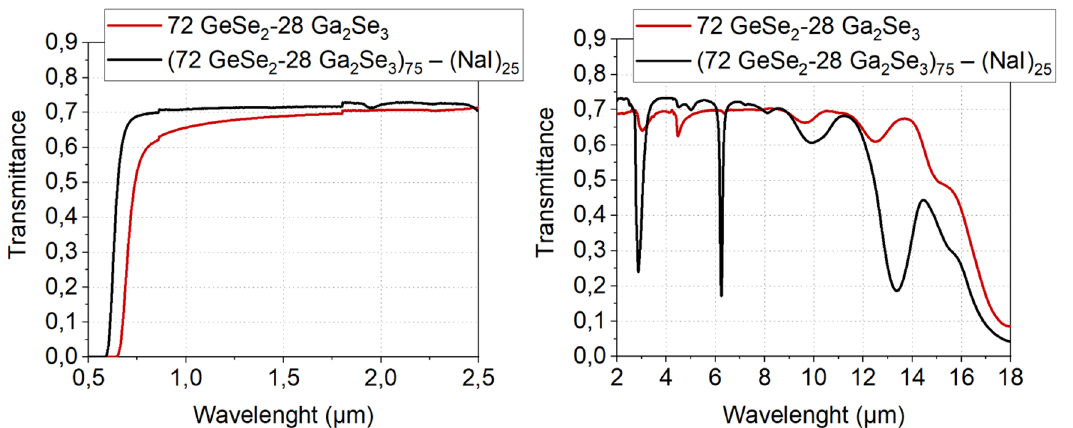
Figure 1. IR transmission of the 72 GeSe 2 –28 Ga 2 Se 3 and the (72 GeSe 2 –28 Ga 2 Se 3 ) 75 (NaI) 25